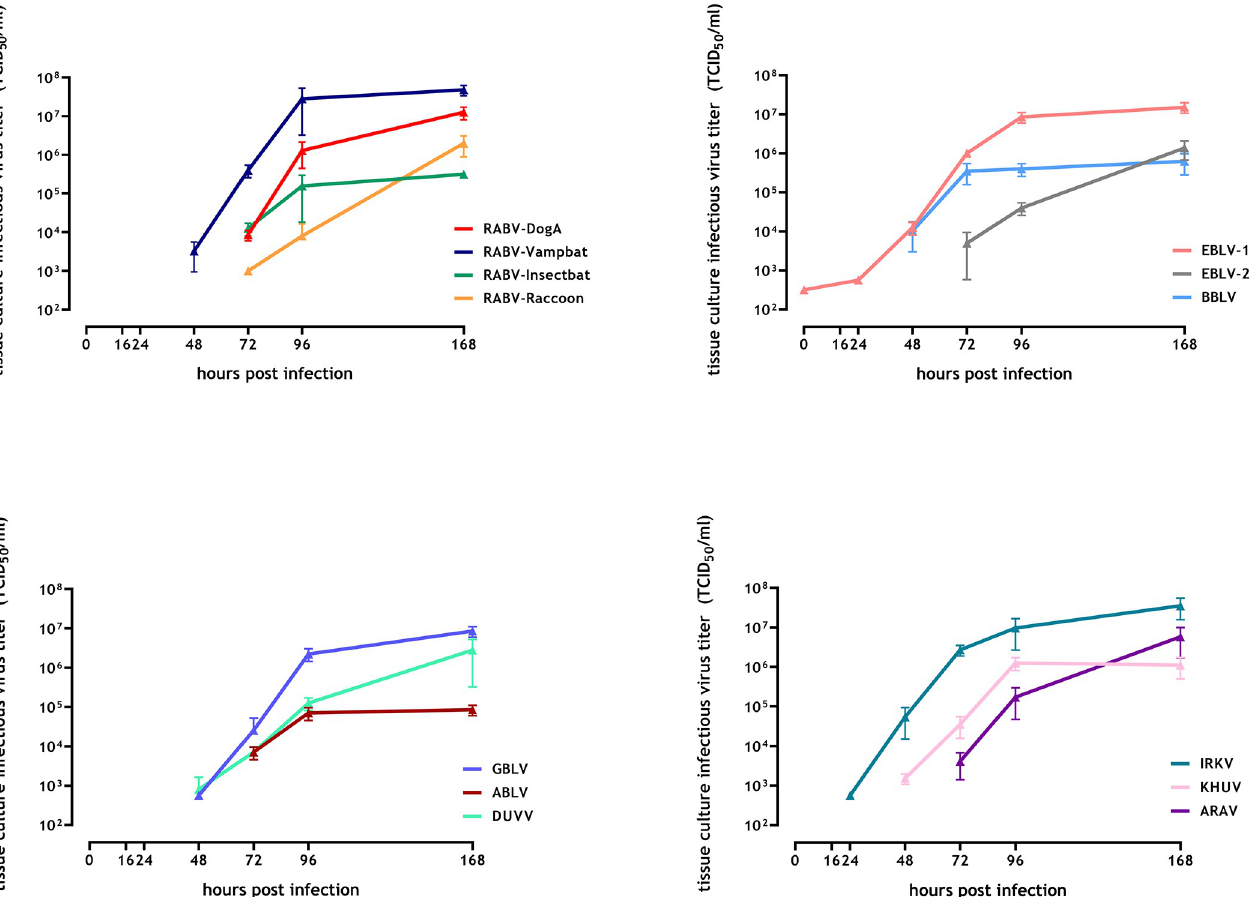
Fig 1. In vitro replication kinetics of lyssavirus isolates in Na 42/13 cells infected with a MOI of 0.001. The mean and standard errors of three replicates are indicated.